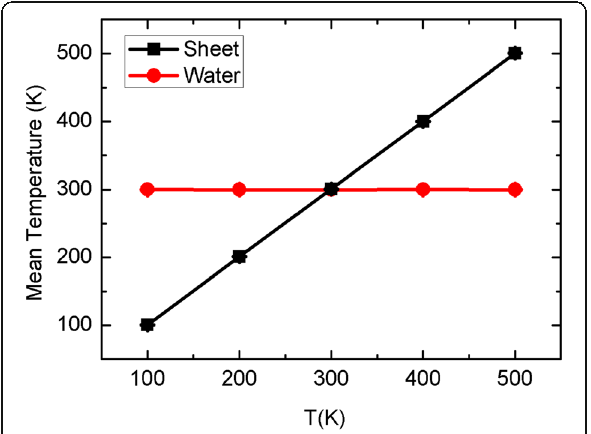
Fig. 10 The mean temperatures of sheet and water as a function of the target sheet